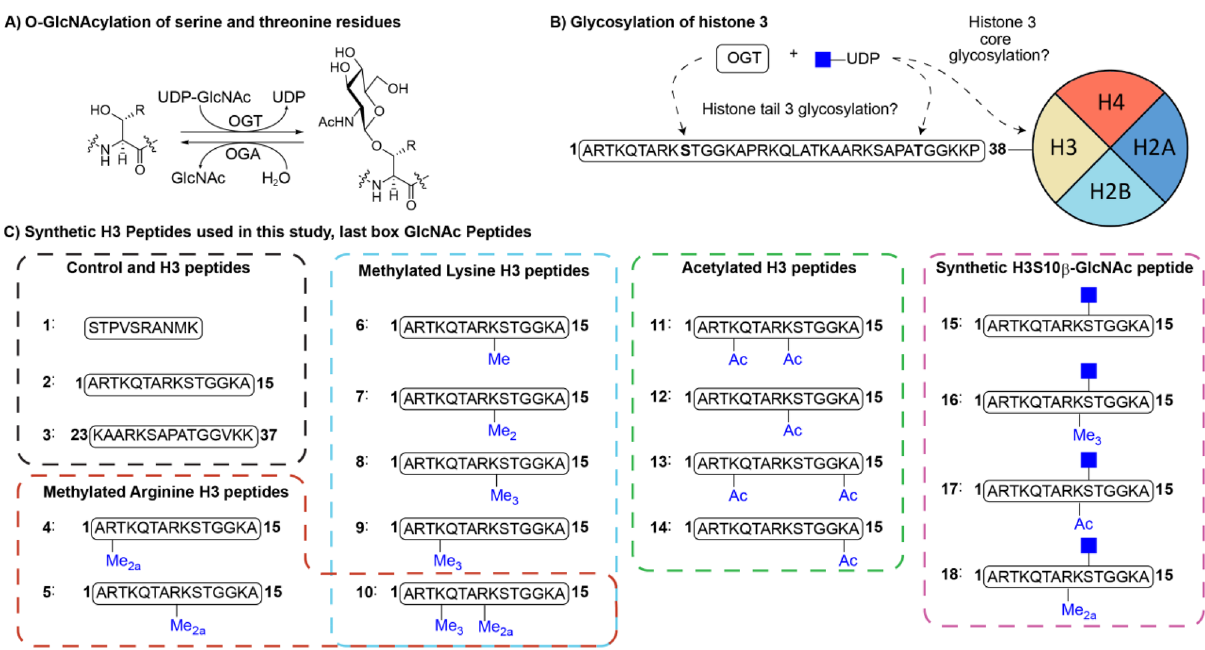
Figure 1. ( A ) OGT catalyzes the transfer of UDP-GlcNAc to serine/threonine residues. OGA hydrolyses the GlcNAc-possessing serine/threonine residues resulting in native serine (R = H)/threonine (R = CH 3 ), ( B ) Identified sites of O-GlcNAc modification of histone H3, ( C ) Histone peptides and controls used in this study. Me = methyl, Me 2 = dimethyl, Me 2a = asymmetric dimethyl, Me 3 = trimethyl, Ac =